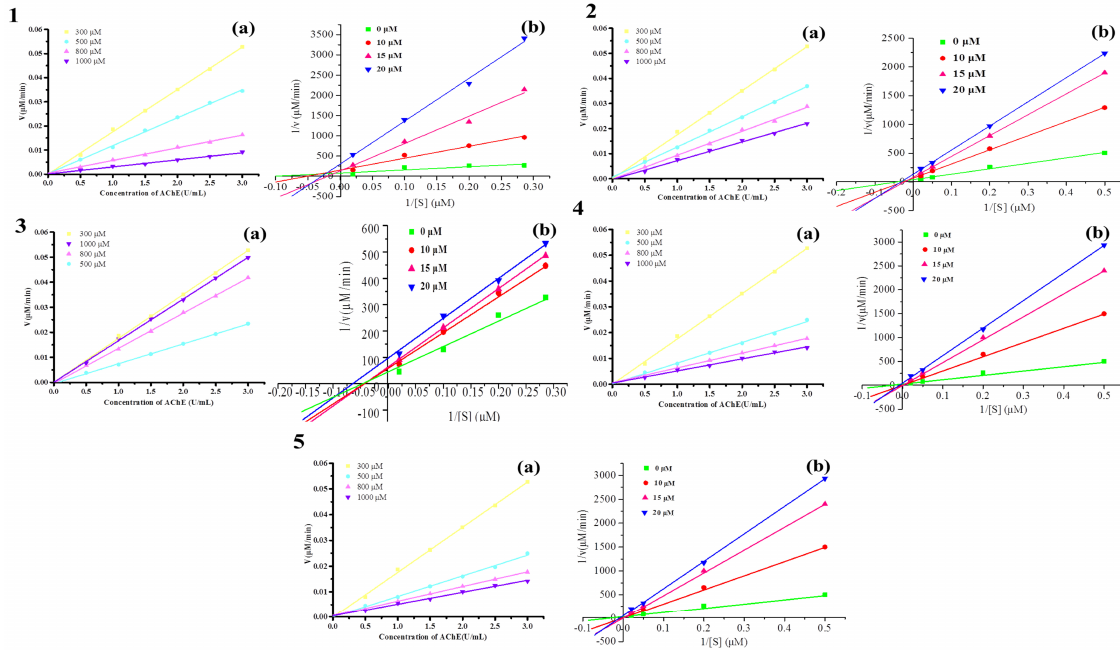
Figure 8. (1( a ), 2( a ), 3( a ), 4( a ), 5( a )) The measurement curve of inhibition type; (1( b ), 2( b ), 3( b ), 4( b ), 5( b )) Lineweaver − burk curve of the inhibitory effect on AChE of active compounds. (1) Tumulosic acid; (2) Polyporenic acid C; (3) 3 − Epidehydrotumulosic acid; (4) Pachymic acid; (5) Dehydrotrametenolic acid.